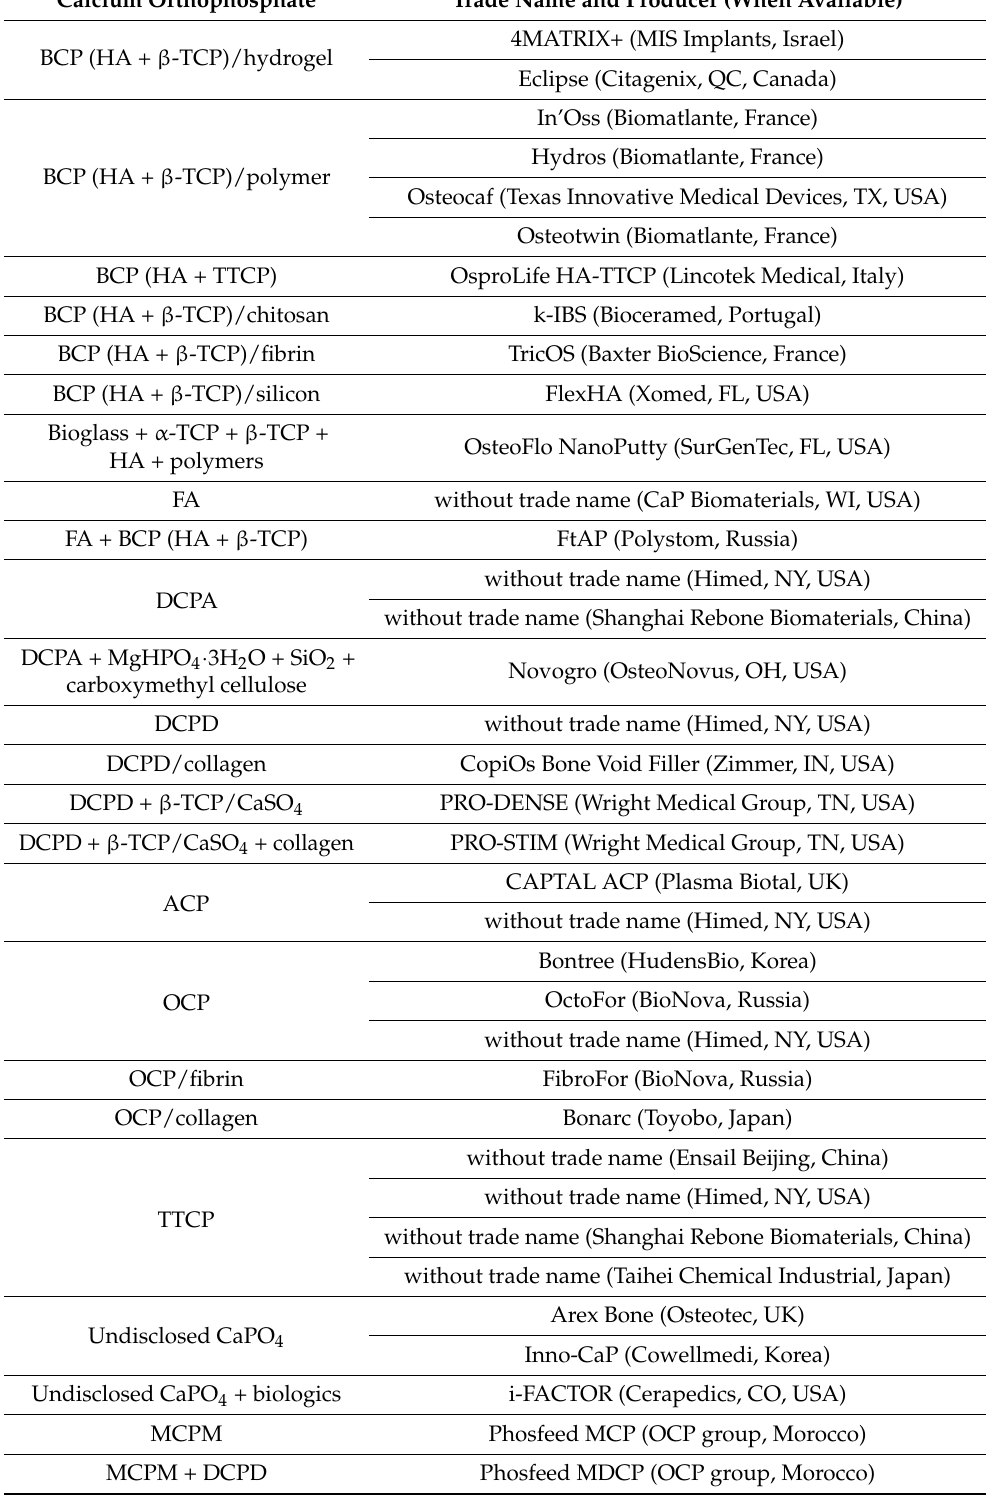
Table 3. Cont . Calcium Orthophosphate Trade Name and Producer (When Available) BCP (HA + β